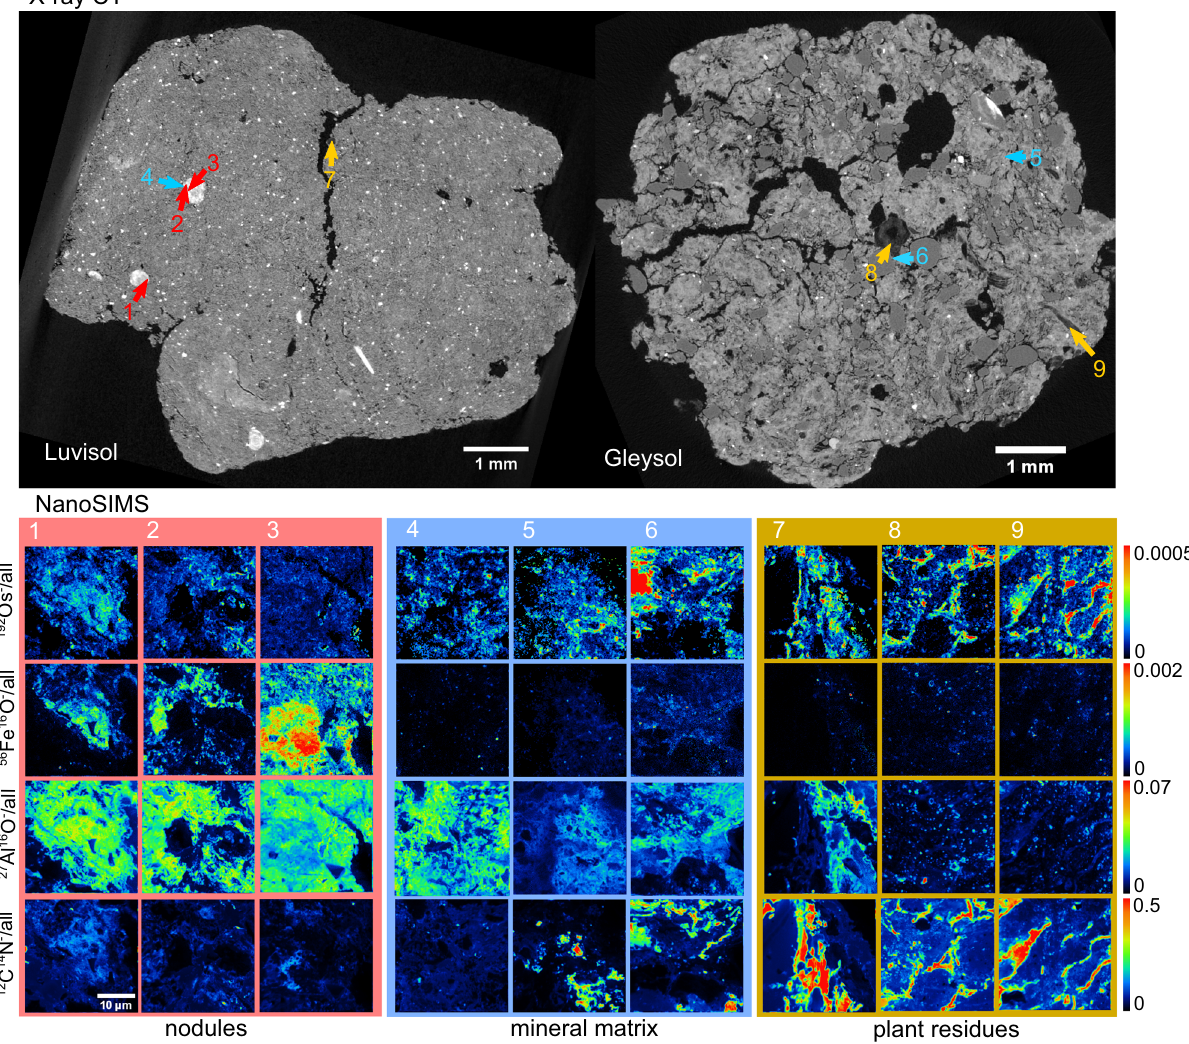
Fig. 4 Correlative microscopy reveals Osmium sorption mechanisms. Two-dimensional cross-sections through tomograms (X-ray CT) of aggregates from a Stagnic Luvisol and a Fluvic Gleysol scanned after Os staining. Nine out of 15 spots mapped with secondary ion mass spectroscopy (NanoSIMS) across both soil sections were selected to depict the spatial distribution of organic C ( 12 C 14 N − /all) and Os ( 192 Os − /all) and its co-localization with Fe ( 56 Fe 16 O − /all) and Al ( 27 Al 16 O − /all) in different microenvironments (Fe-rich nodules (red), mineral matrix (blue), plant residues